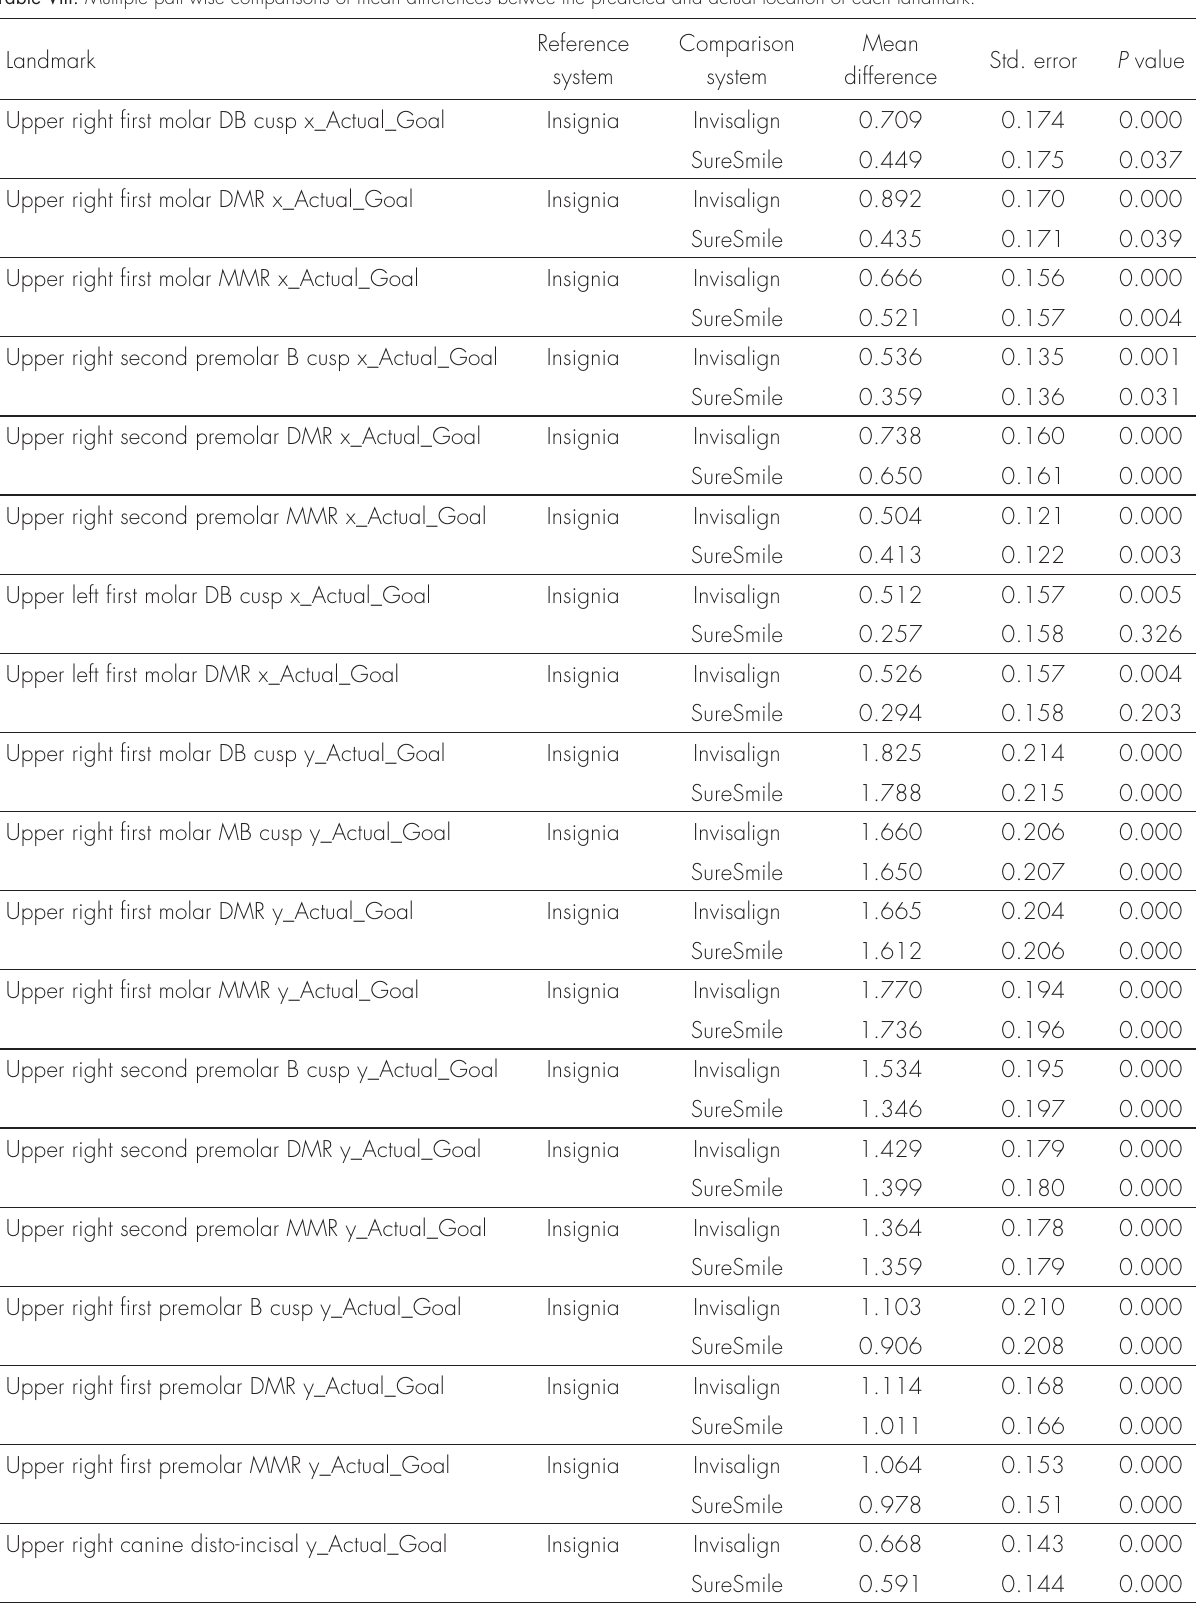
Table VIII. Multiple pair-wise comparisons of mean differences betwee the predicted and actual location of each